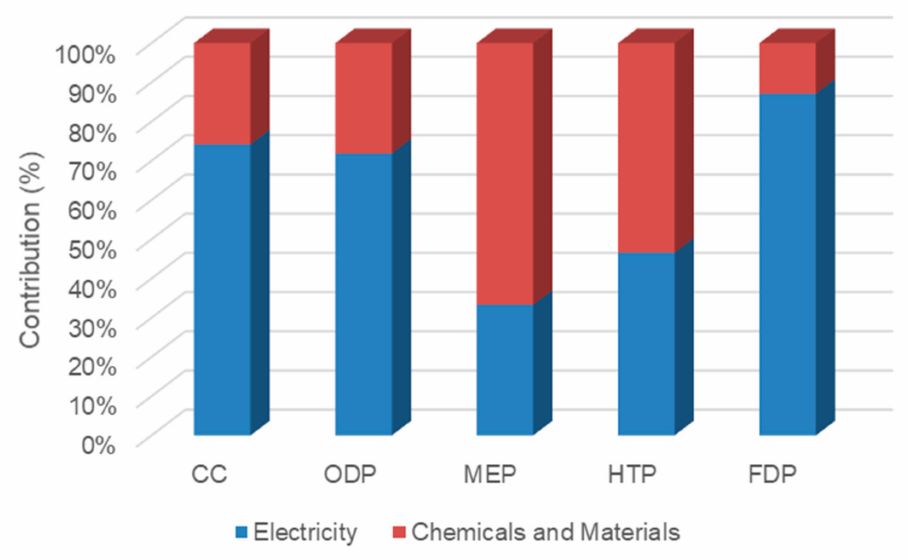
Figure 11. The contribution of inventories in midpoint impacts of case